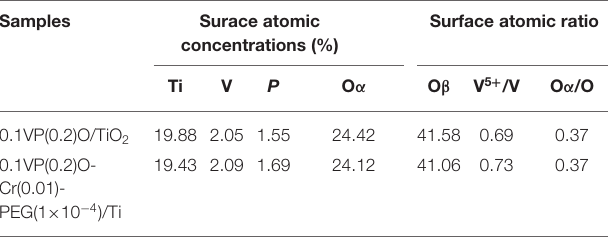
TABLE 2 | Element content of catalysts. Samples Surace atomic concentrations